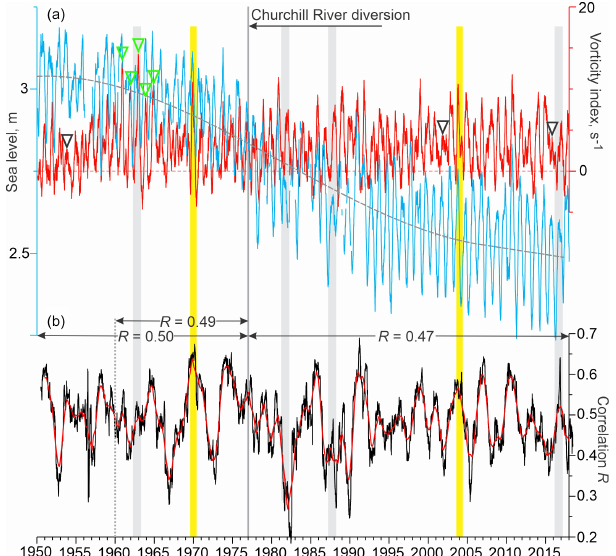
Figure 4. (a) 30d running mean of the Churchill River discharge (black; 10 2 m 3 s − 1 ) and detrended SLA at Churchill (blue;m). Gray circles show mean discharge pre- and post-diversion with standard deviations depicted with red error bars. (b) Correlation R between daily Churchill River discharge and SLA computed for the 365d moving window (black) with their 365d running mean (red). Pink shading highlights statistically insignificant correlations at the 99% confidence level. Numbers at the top show correlation between daily Churchill River discharge and SLA computed for 1950–1976 and 1977–2018 pre- and post-diversion, respectively. (a, b) Yellow shading highlights August–May 1969–1970 and 2003–2004. Black arrow indicates onset of the Churchill River diversion. Gray